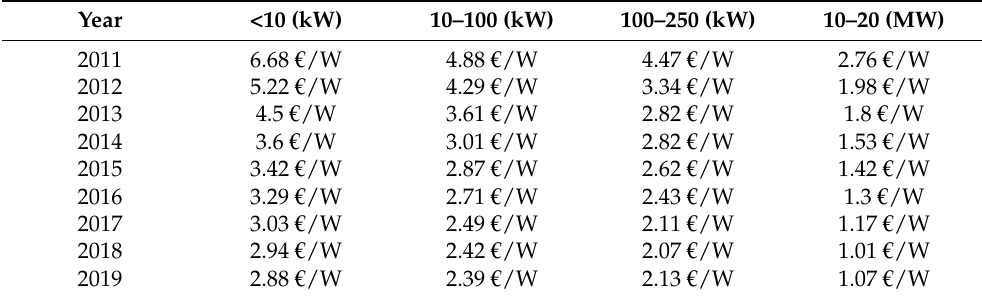
Table 2. Reductions of the concentrating photovoltaic (CPV) unit cost ( € /W) from 2011 to 2019 for four categories with different power sizes